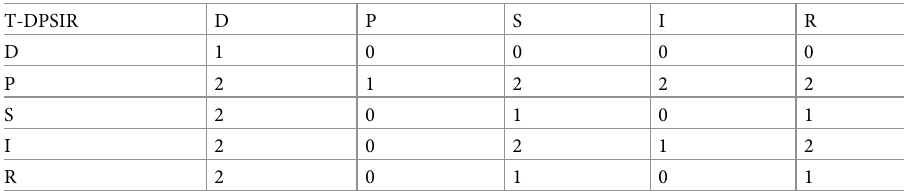
Table 2. Comparison matrix of land-based ecological security indicators.